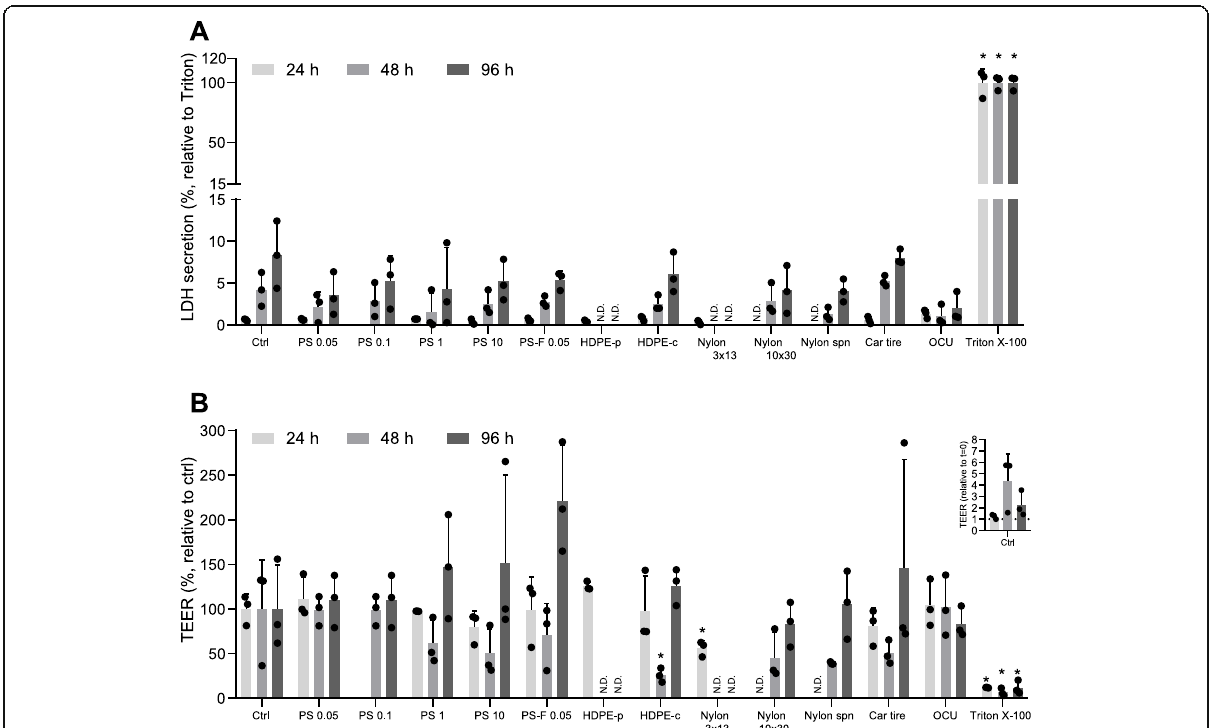
Fig. 2 Viability and integrity measurements in the lung epithelial cell model MucilAir ™ upon 24, 48, and 96 h exposure to MNP (1 mg/mL). A The release of lactate dehydrogenase (LDH) into the basolateral compartment was measured as a marker of cell viability. Maximum LDH release was achieved by exposure to Triton X-100 0.1%, and all other values were expressed as percentage relative to the maximum release. B Transepithelial electrical resistance (TEER) as marker for barrier integrity was measured before (t = 0 h) and after exposure. Per condition, TEER at t = 0 h was normalized to 1 and subsequent measurements were expressed relative to t = 0 h. Additionally, at every timepoint, ctrl TEER was set at 100%, and all other values were expressed as percentage relative to the ctrl. Inset: relative TEER under control conditions over time. TEER at t = 0 h was normalized to 1 (dotted line) and subsequent measurements were expressed relative to t = 0 h. Data are presented as mean ± SD. * p < 0.05 compared to the control condition, calculated by one-way ANOVA (Dunnett ’ s multiple comparisons). N.D. = not